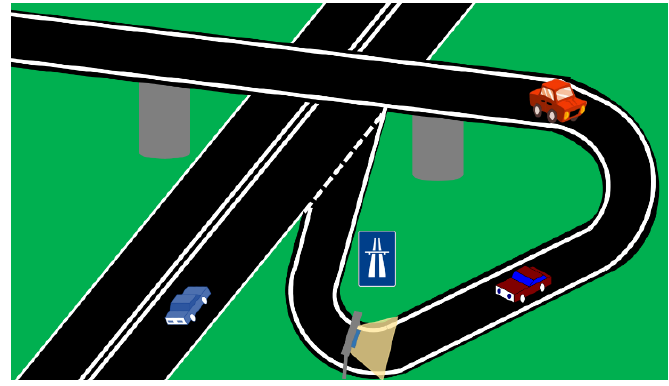
Figure 1. Highway tolling system in access lane.